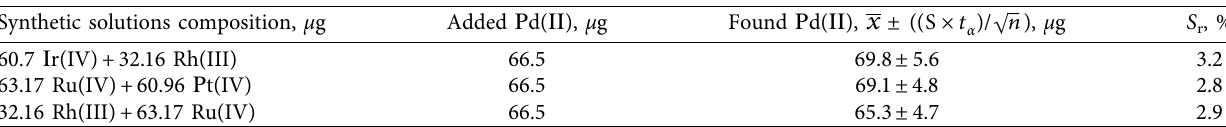
� 7.50 · 10 − 5 mol · L − 1 ; C � 0.10 mol · L − 1 ; p -ITYBA N a Cl